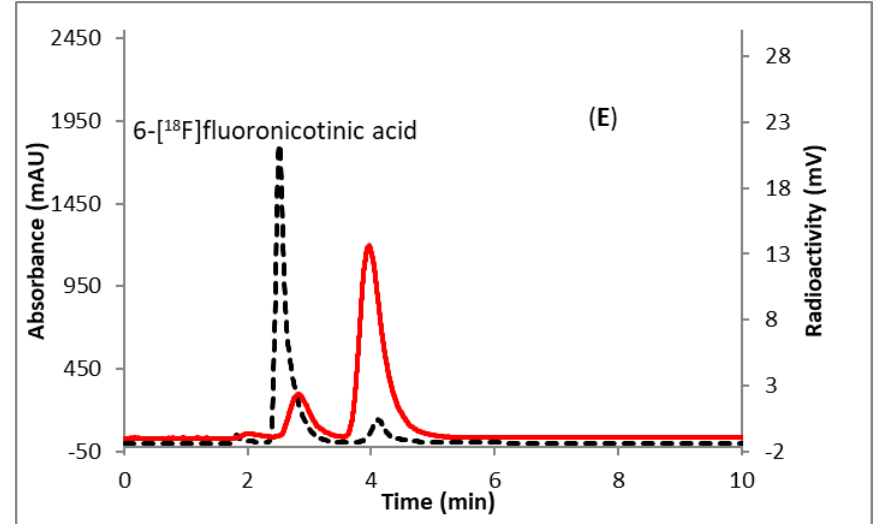
Figure 2. HPLC analysis (method B) of 6-[ 18 F]SFPy ( A ) Crude reaction mixture; ( B ) Crude reaction mixture co-injected with the non-radioactive standard; ( C ) Pure; ( D ) Pure co-injected with the non-radioactive standard; ( E ) After 4h of labeling at room temperature co-injected with the non-radioactive standard, 6-fluoronicotinic acid. Solid line, in-line radio detector; dotted line, UV detector at 254 nm. Retention time (min): 6-[ 18 F]SFPy, 4.0; compound 4 , 4.1; 6-[ 18 F]fluoronicotinic acid, 2.8.